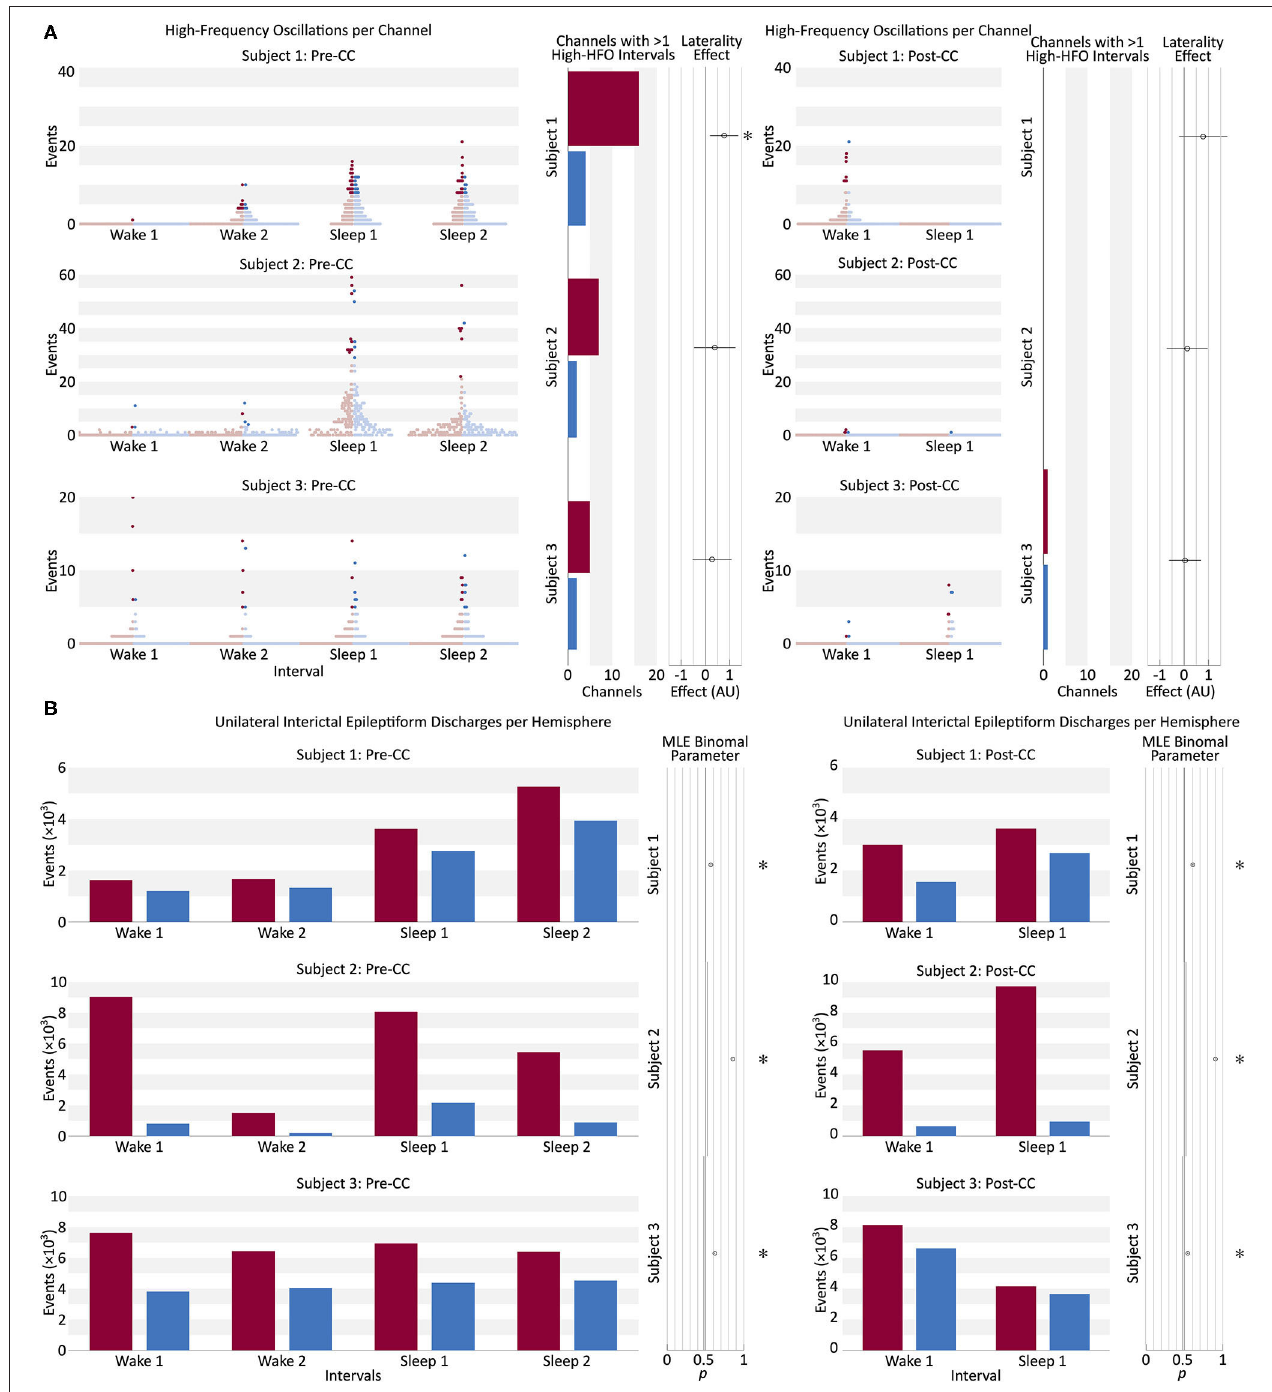
FIGURE 5 | (A) Beeswarm boxplot representing the distribution of HFO counts per channel in each of four pre-CC and two post-CC 30-min baseline segments of interictal intracranial EEG in the three subjects. Two pre-CC and one post-CC baselines from each subject were taken from periods of quiet wakefulness (Wake), and the same number from periods of sleep (Sleep). Each red dot represents a single EEG channel from the hemisphere identified post-CC as predominantly pathologic, and each blue dot represents a channel from the contralateral hemisphere. The intensely-colored dots represent channels that meet the robust half-maximum criterion, and the pale dots represent those that do not. The bar graphs for each subject show the number of channels from the more-pathologic (red) and less-pathologic (blue) hemispheres that met the robust half-maximum criterion during at least two of the baseline intervals. The circle markers show the effect of